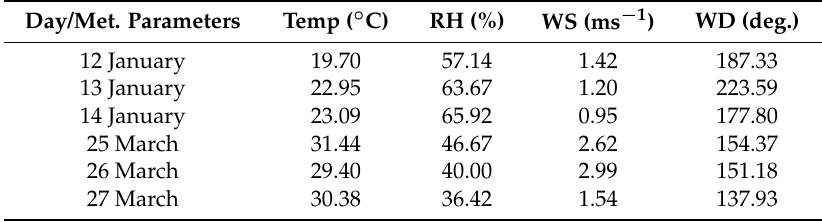
Figure 3. Day-to-day variability in the surface meteorological parameters ( a ) temperature (temp. °C), ( b ) relative humidity (%) (RH), ( c ) wind speed (ms − 1 ) (WS), and ( d ) wind direction (deg.) (WD) at Singrauli during January–March 2013. Table 1. Values of the surface meteorological parameters temp., RH, WS, and WD at Singrauli during measurement days of January and March 2013.